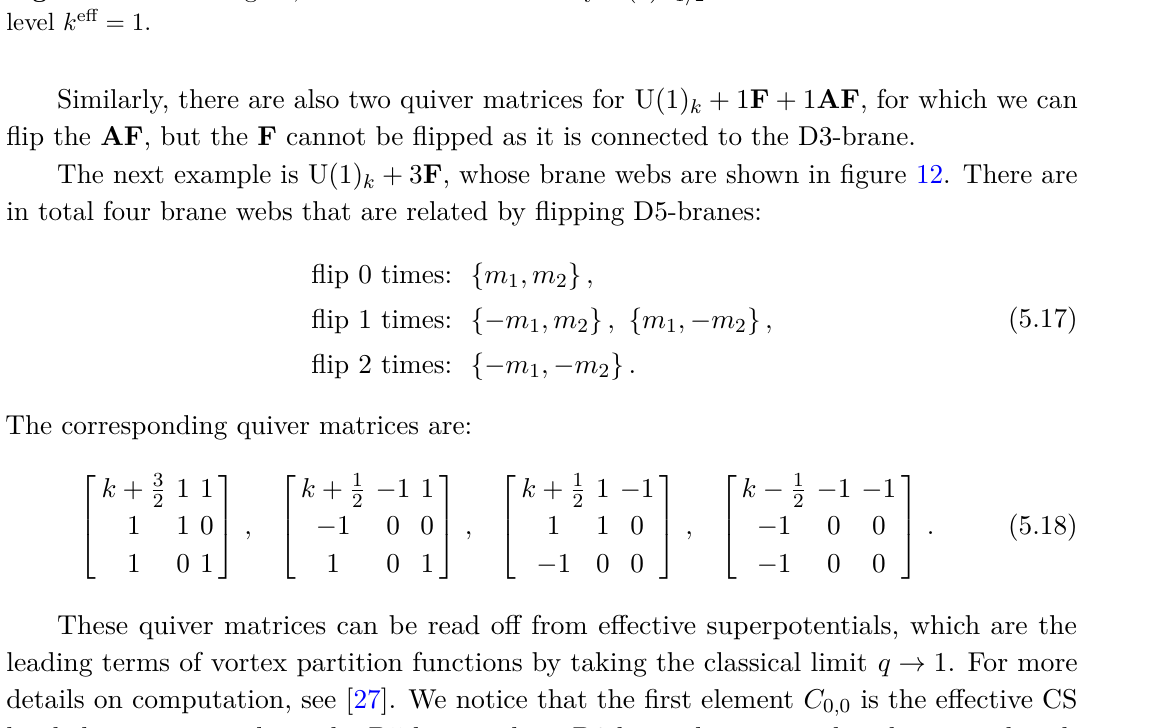
+ 3 F have the same effective CS − 1 / 2